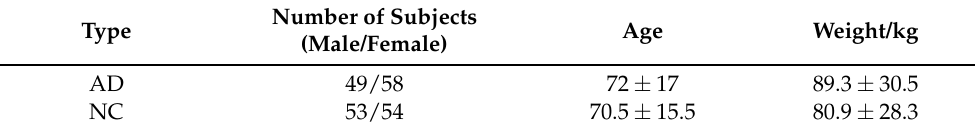
Table 2. The details of ADNI